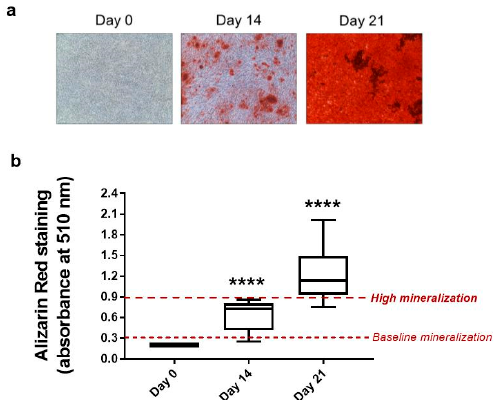
Figure 3. Mineral apposition in control osteogenic cultures of hMSCs. ( a ) Representative pictures of Alizarin Red staining in osteogenic cultures of hMSCs (magnification 100 × ). ( b ) Box plot showing the quantification of mineral apposition at day 0, day 14, and day 21 in control cells. Data are expressed as median ± min–max values of six independent experiments. Wilcoxon signed-rank test vs. 0.2 value (no mineralization) was performed for the statistical analysis (**** p < 0.0001 vs. control day 0). When hMSCs were stimulated with different concentrations of GRA (3.3, 10, 33, and 100 μ M), we observed an increase in the mineral matrix apposition (Figure 4a,b). The sig- nificant increase in mineralization by GRA stimulation was evident at the early time point day 14, where the majority of unstimulated cells were still in the exponential phase and expressed different grades of mineral deposition. As reported in Figure 4a, the highest relative increase in mineralization was observed at the highest dose of 100 μ M ( p < 0.01); however, GRA induced a similar increase in mineralization even at the low dose of 3.3 μ M; ( p < 0.05). By day 21, when the mineralization had levelled off and reached the highest levels even in control samples, GRA-treated samples still showed a slightly higher density of mineralized extracellular matrix compared to unstimulated samples (Figure 4b). How- ever, the magnitude of the increase was lower, and none of the concentrations achieved statistically significant differences compared to controls.